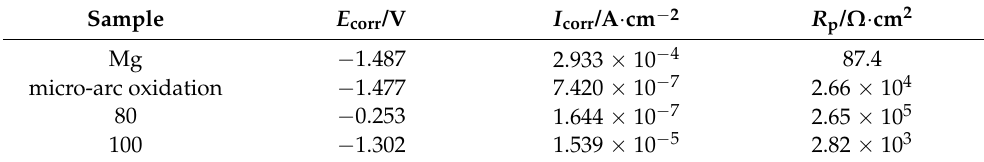
Table 2. Electrochemical parameters of Mg, micro-arc oxidation, 80 wt%, and 100 wt%